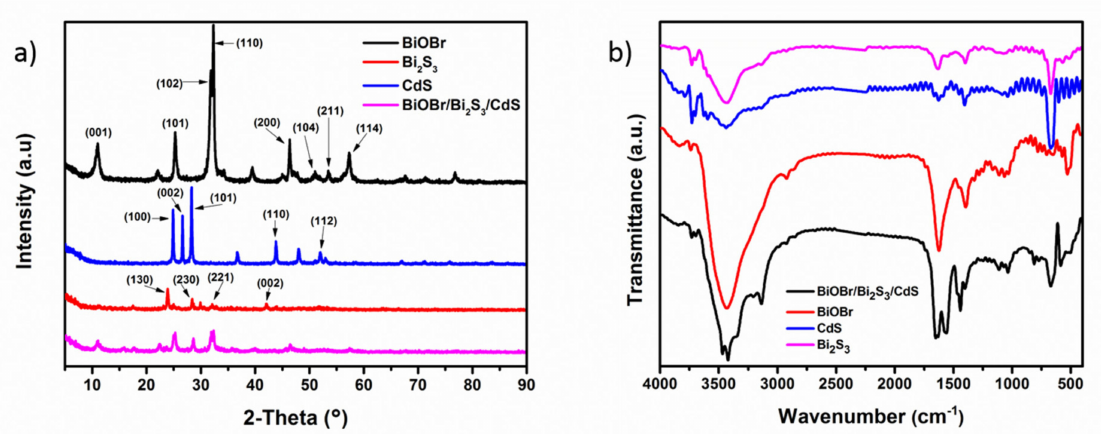
Figure 1. ( a ) XRD patterns of BiOBr, CdS, Bi 2 S 3 , and BiOBr/Bi 2 S 3 /CdS. ( b ) FT-IR spectra of Bi 2 S 3 , CdS, BiOBr and BiOBr/Bi 2 S 3